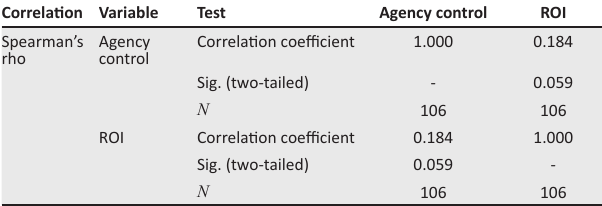
TABLE 4: Spearman’s correlation on agency control versus return on